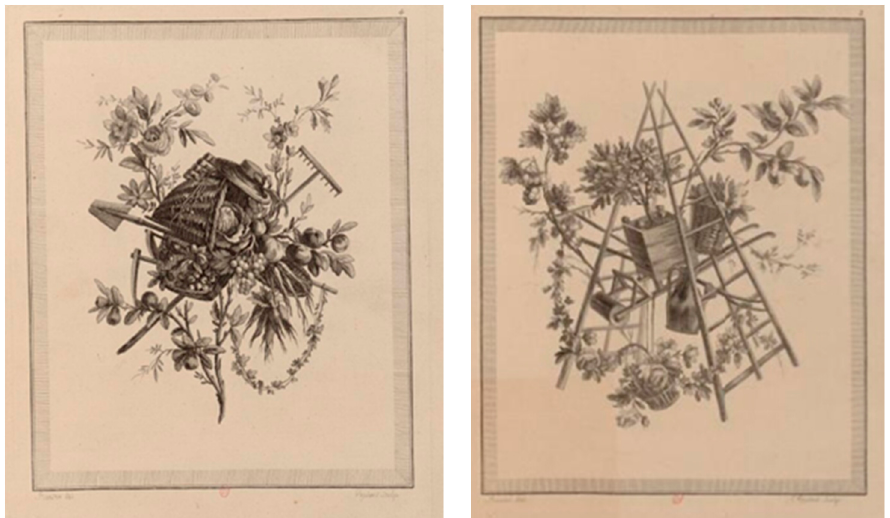
Figure 16. Pierre Ranson (1736–1786), Oeuvres Contenant un Recueil de Trophées, Attributs, Cartouches, Vases, Fleurs Ornemens Et Plusieurs Desseins Agréables pour Broder des Fauteuils; Composés et Dessinés par Ranson, et gravés par Berthaut et Voysard (Paris: Ranson 1778).